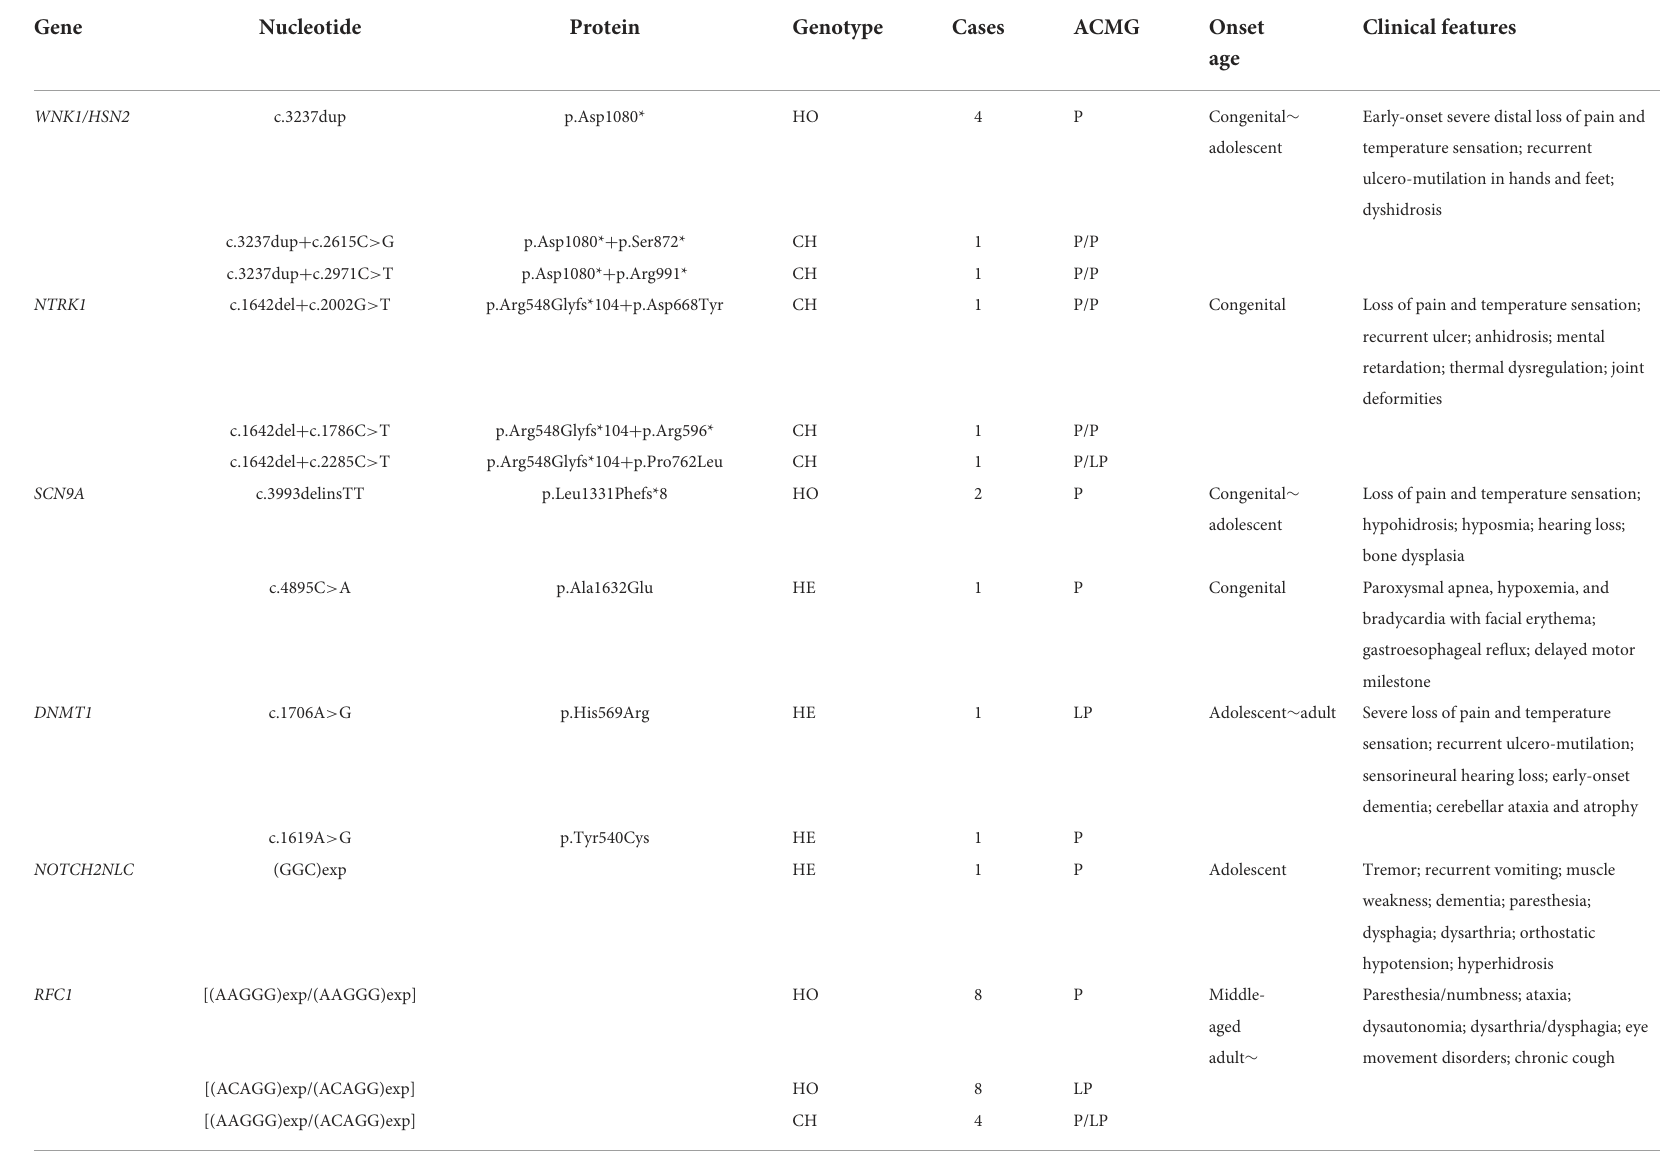
TABLE 1 All pathogenic/likely pathogenic variants detected by genetic studies and clinical features of our